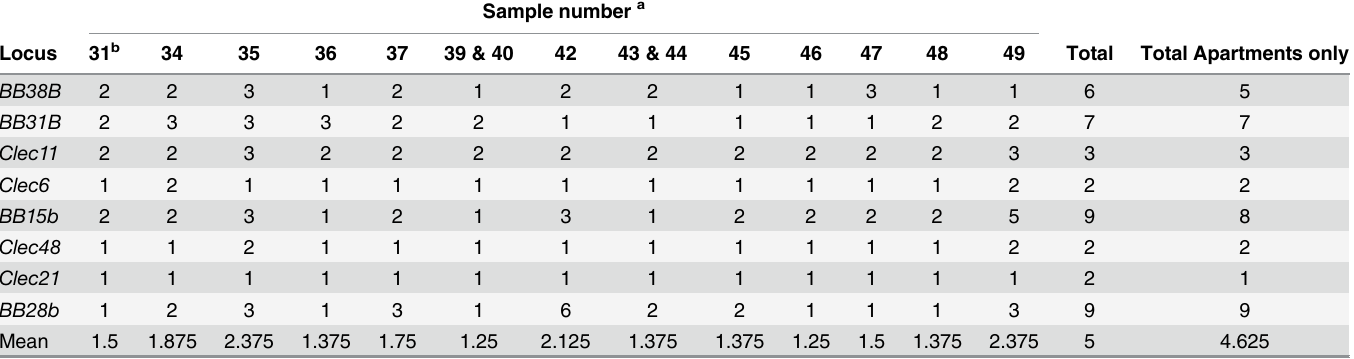
Table 4. Number of microsatellite alleles present in each sample.